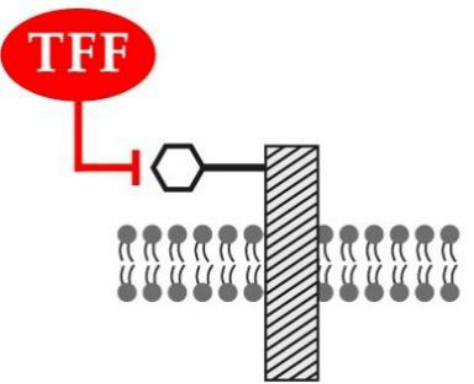
Figure 4. Lectin-triggered receptor blocking hypothesis. TFF peptides are proposed to bind as lectins to the carbohydrate moiety (indicated by a hexagon) of a glycosylated transmembrane receptor (hatched rectangle), thus negatively interfering with the binding of the natural ligand(s).